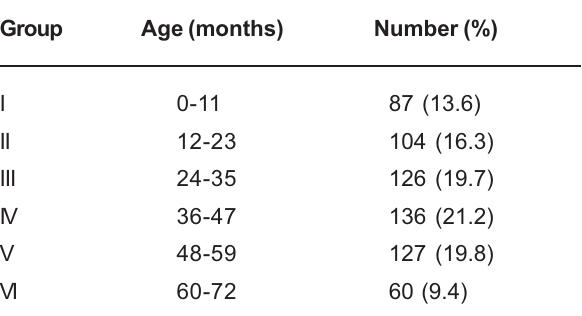
TABLE 1- Distribution of the children according to their